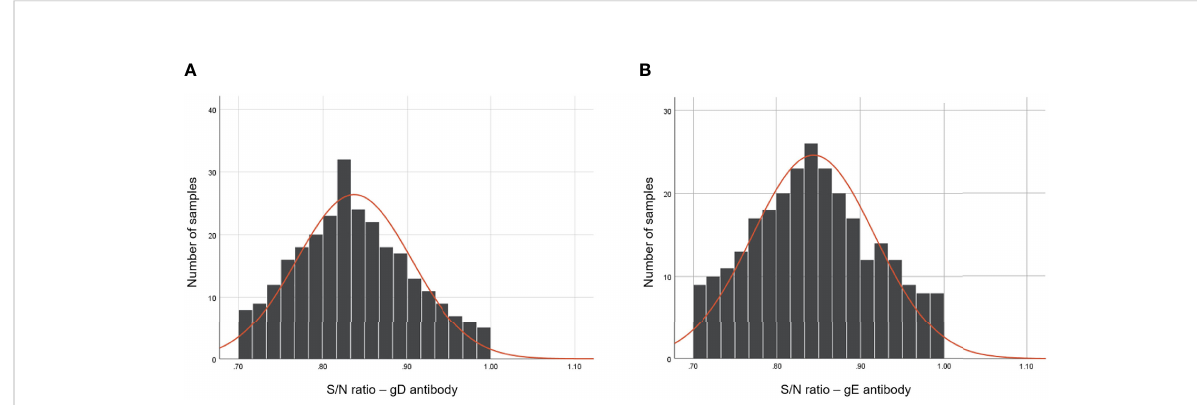
FIGURE 3 Frequency analysis of PRV gD and gE Abs-negative serum samples using the dual-detection chip platform. The S/N values of gD (A) and gE (B) Abs of 270 Ab-negative serum samples after the detection of the dual detection chip platform. The frequency distribution of the tested serum samples was constructed using GraphPad Prism